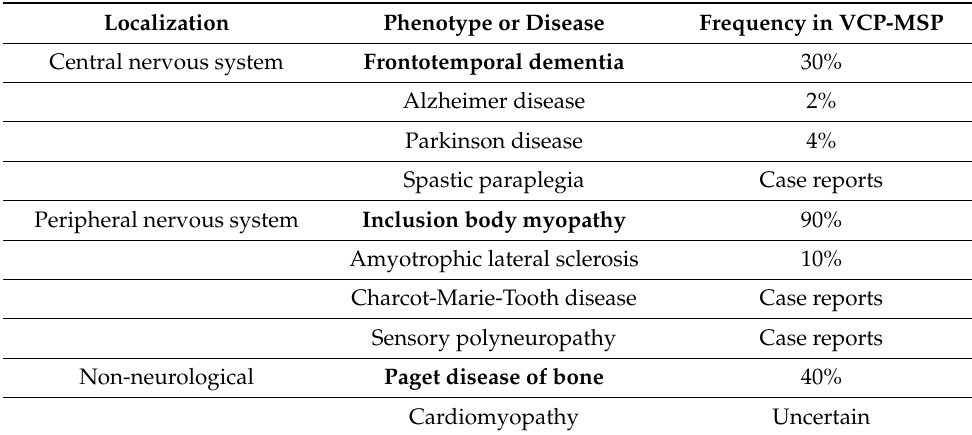
Table 1. Neurological localizations and clinical phenotypes associated with